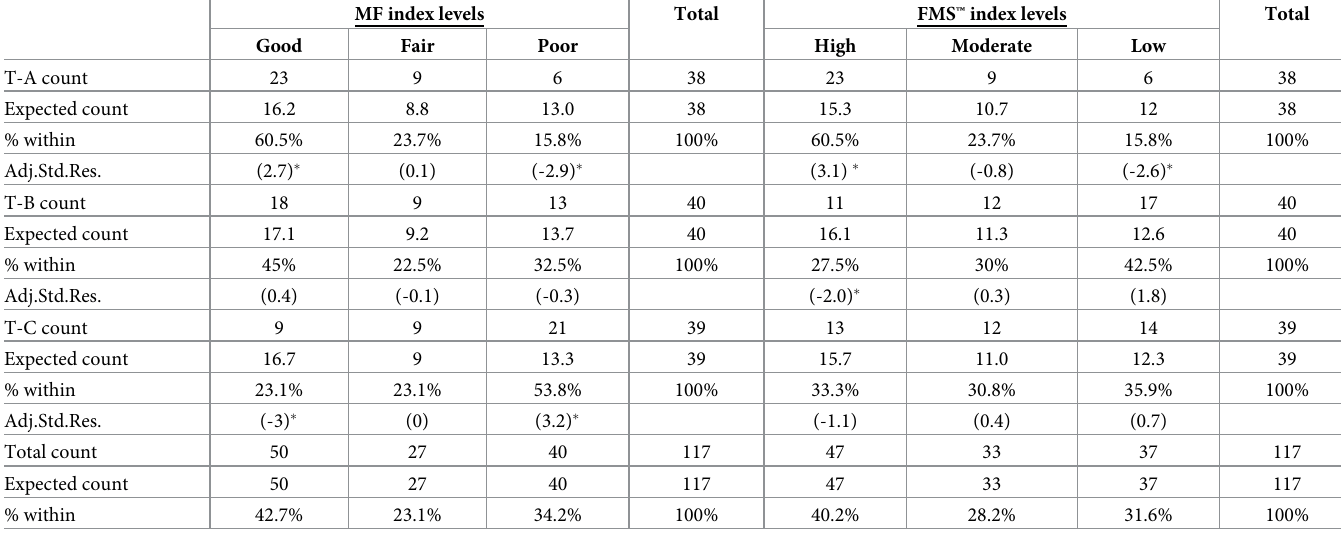
Table 5. Chi-Square Cross-Tabulations indexes for FMS levels × MF levels and FMS levels × FMS ™